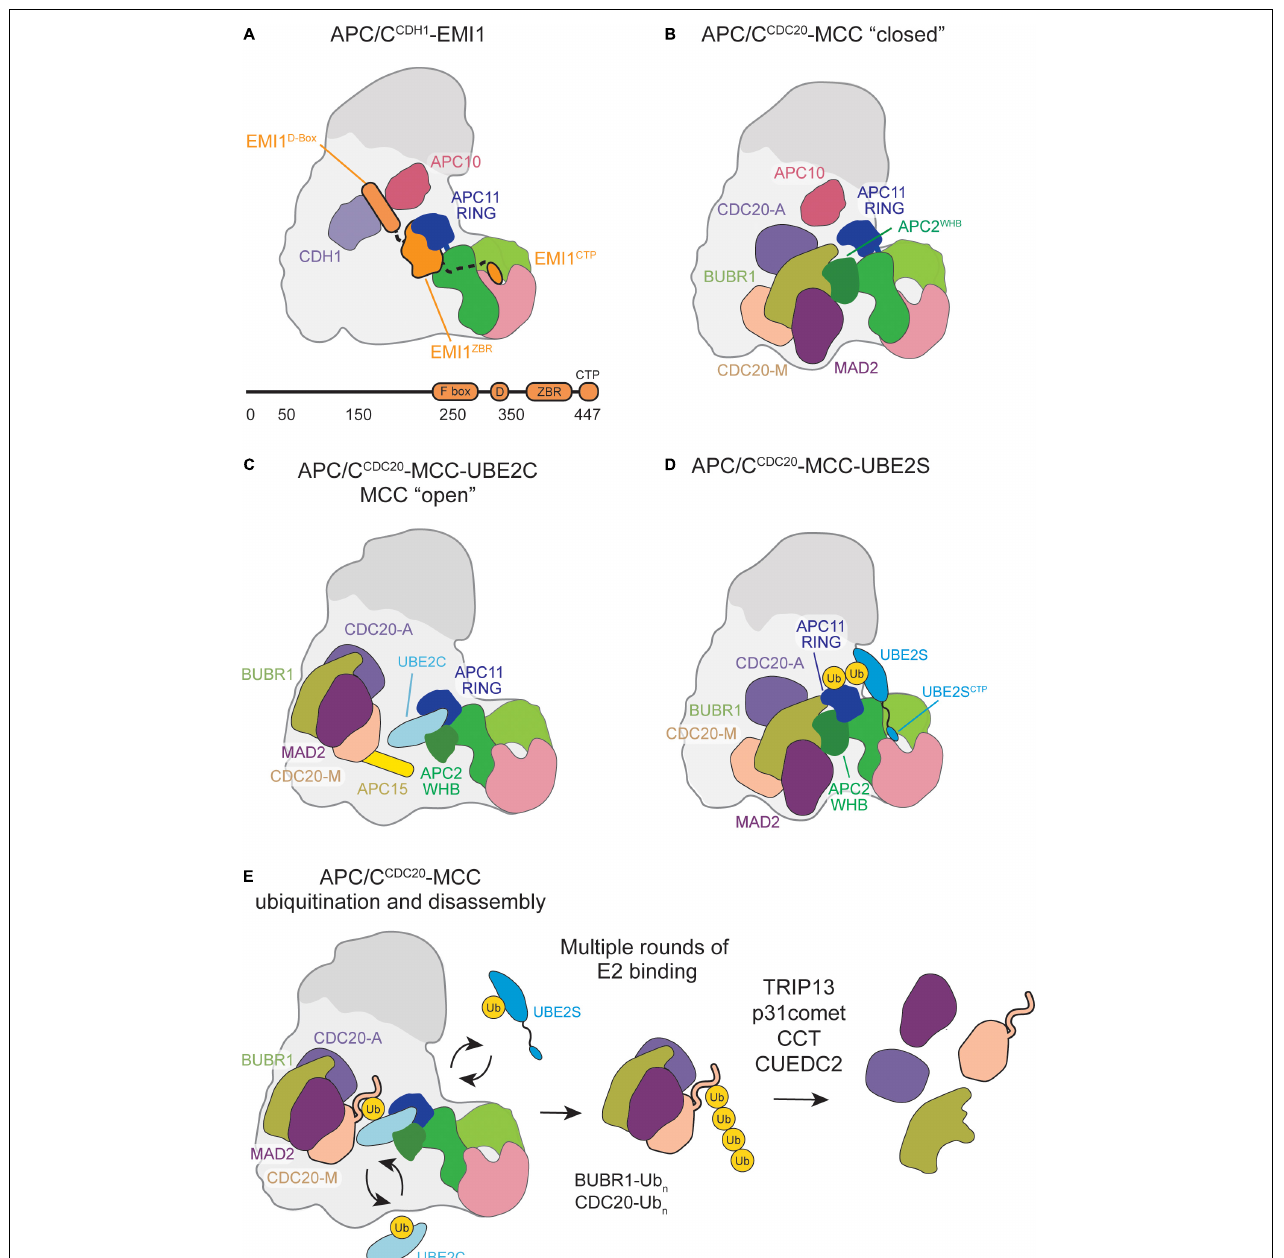
FIGURE 3 | Schematic of APC/C inhibition by EMI1 or MCC binding. (A) EMI1 binds in a multimodal fashion, the D-box binds at the CDH1-APC10 D-box receptor site, binds and immobilizes the APC11 RING, and contains a CTP similar to the UBE2S CTP that binds in the APC2/4 groove. (B) MCC bound to the APC/C in a “closed” conformation engages the APC2 WHB and CDC20 A . (C) MCC transitions to an “open” conformation, allowing UBE2C to bind, and some substrates, such as Cyclin-A and NEK2A, to bypass MCC inhibition and be ubiquitinated by the APC/C. (D) MCC in the “closed” conformation permits UBE2S to bind, allowing for Ub chain elongation to occur. (E) Multiple rounds of E2 binding result in the polyubiquitination of several MCC subunits. CCT/TRiC and TRIP13-p31 comet assist in the release CDC20 and MAD2, respectively, from